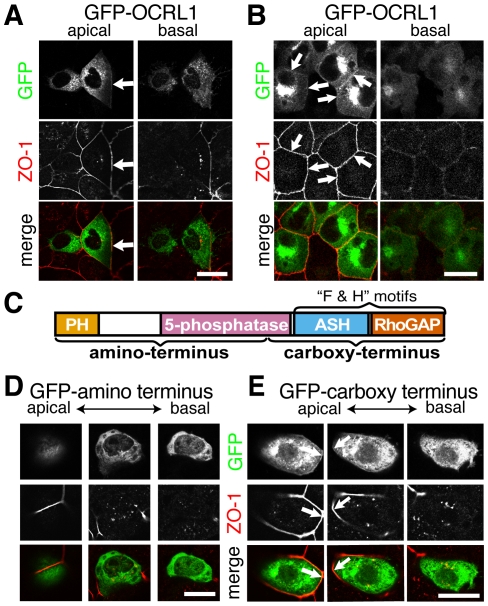
Junctional localization is determined by the carboxy-terminus of OCRL1 and is conserved in Inpp5b.GFP-tagged constructs were transfected into cells at low confluency: (A, D, E & F) Caco-2, (B) MDCK. (C) Domain structure of OCRL1, indicating constructs used in this figure, and the region of OCRL1 known to bind “F & H” motifs. Constructs used: (A & B) GFP-OCRL1, (D) GFP-OCRL1–amino-terminus, (E) GFP-OCRL1–carboxy terminus. 24 hours post-transformation, cells were fixed in methanol and processed for ZO-1 immunostaining as in Figure 1B. In all cases, apical and basal confocal sections are compared, with intermediate sections included where they add information. For full length OCRL1 (A and B), and for OCRL1-carboxy terminus (E), GFP-tagged constructs (top panels) partially colocalize (arrows) with apical junctions, as marked by ZO-1 (bottom panels), but there is no peripheral GFP in basal sections. By contrast, GFP-OCRL1-amino terminus (D) is not at apical junctions. Scale bars are 10 µm.